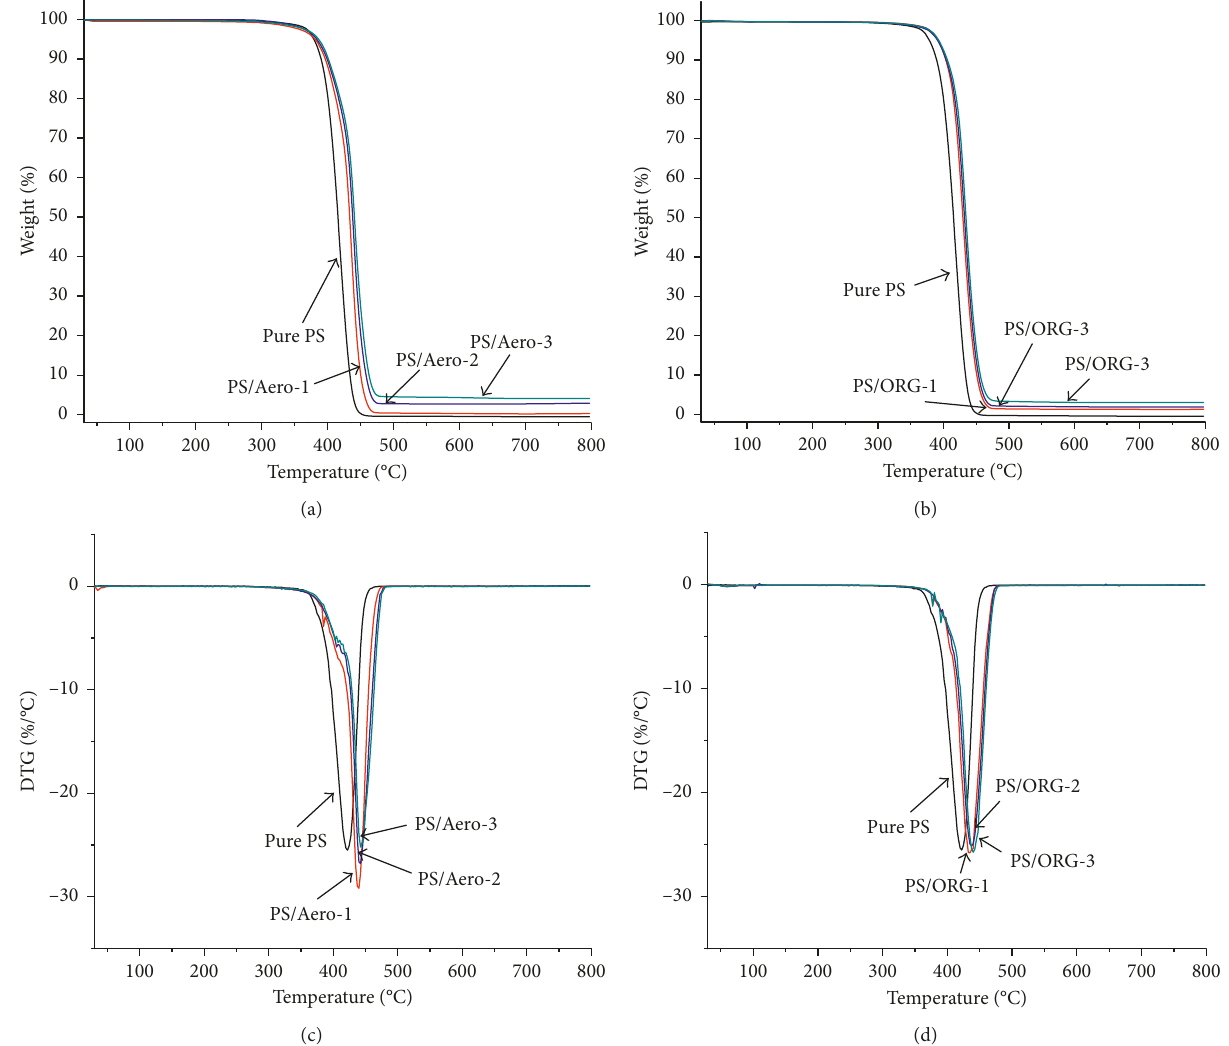
Figure 11: TGA and DTG thermograms of PS/clay nanocomposites prepared from the nanoclay aerogel masterbatch and